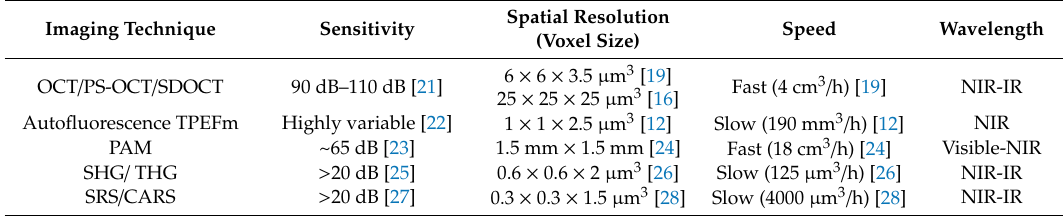
Table 1. A comparative table for di ff erent intrinsic contrast imaging (ICI) techniques: In the case of autofluorescence two-photon excitation fluorescence microscopy (TPEFm), the sensitivity of the signal is highly dependent on the e ff ective cross section of the excitation from the targeted molecule. Moreover, the examples shown here are dependent on the resolution desired for the microscopic